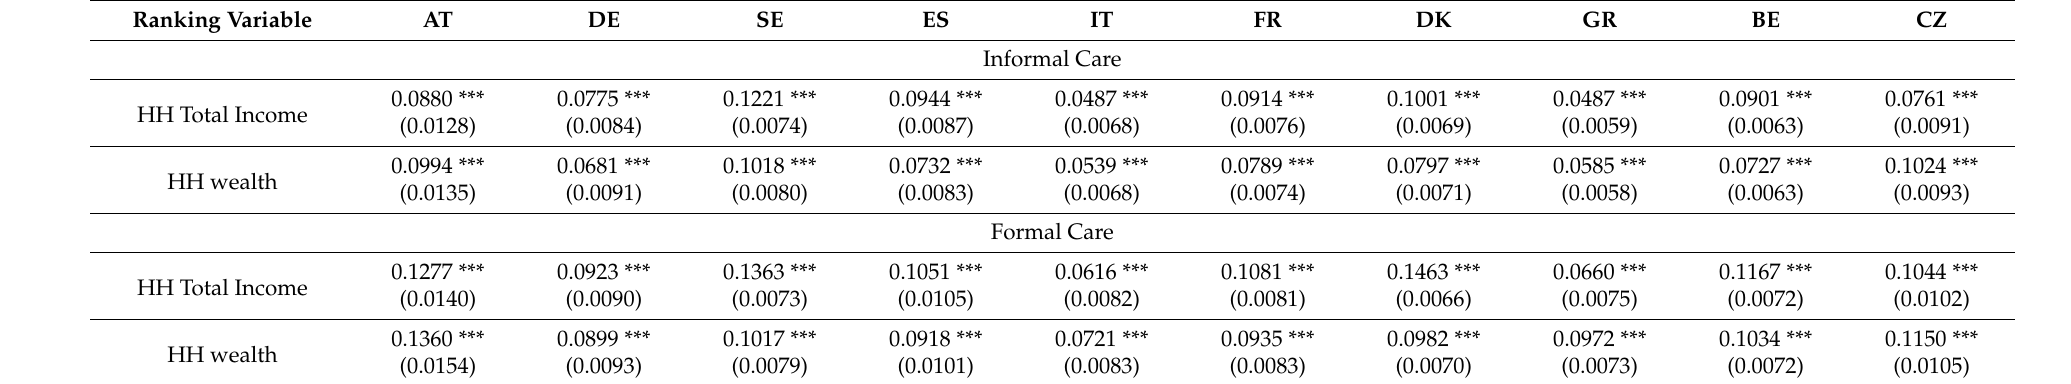
Table 5. Horizontal inequity in the use of